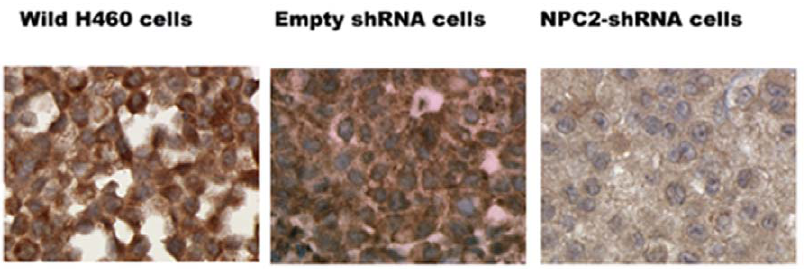
Figure 3. NPC2 protein expression in cultured H460 cells. Immunohistochemical staining showed abundant NPC2 protein in wild and empty vector cells and markedly reduced NPC2 protein in NPC2-shRNA -containing cells.